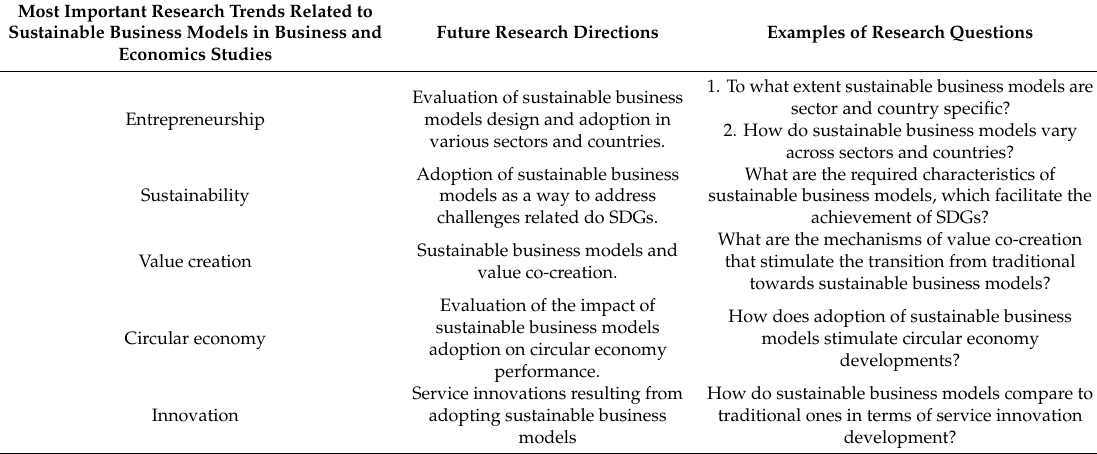
Table 11. Future research directions in investigating sustainable business models from business and economics